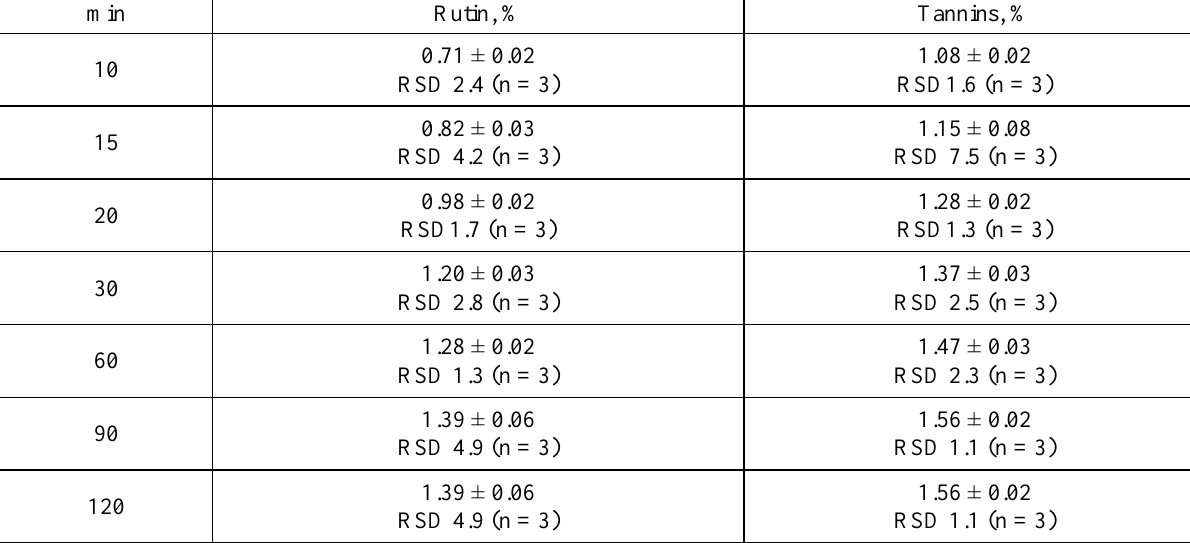
Table 2. Kinetic varieties of 50% aqueous ethanol extract of Cichorium intybus L. leaves in rutin and